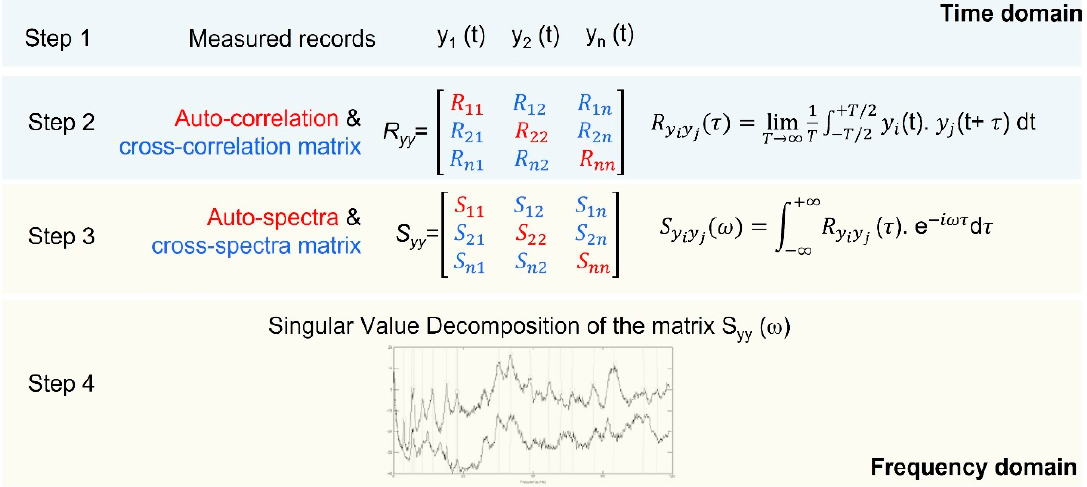
Figure 2. Main steps for the application of the Enhanced Frequency Domain Decomposition (EFDD) method.